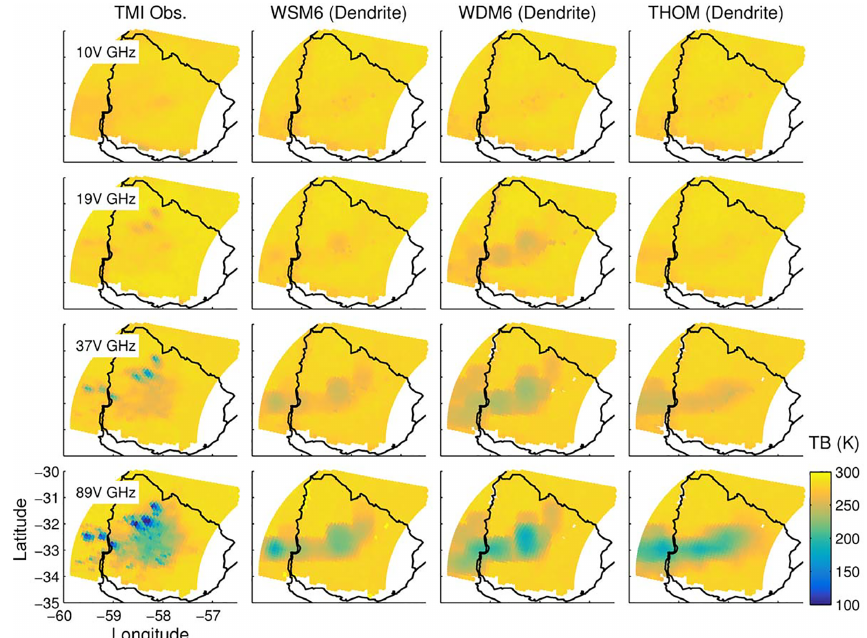
Figure 14. TMI observations at 10V, 19V, 37V and 89VGHz (first column), as compared to the corresponding radiative transfer simulations using the dendrite habits for the WSM6, WDM6 and THOM scheme simulations.